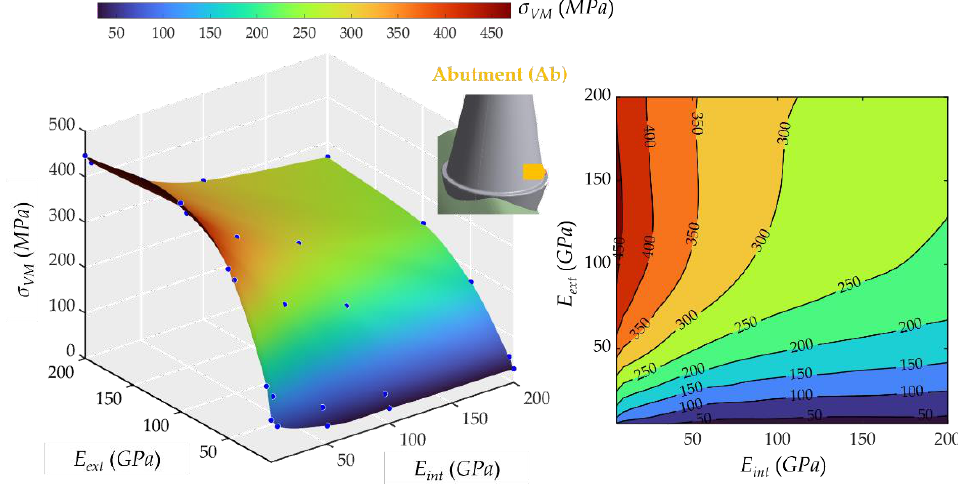
Figure 8. Von Mises maximum stress at the middle part of the abutment (Ab). ( Left ): 3D represen- tation. ( Right ): vertical projection.